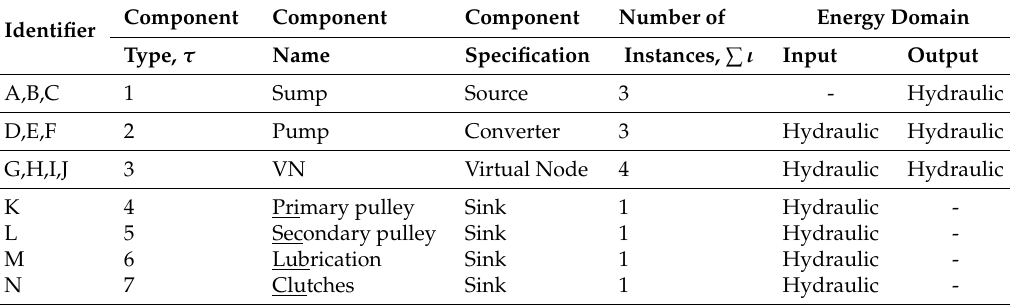
Table 5. Session library: actuation topology design synthesis for a